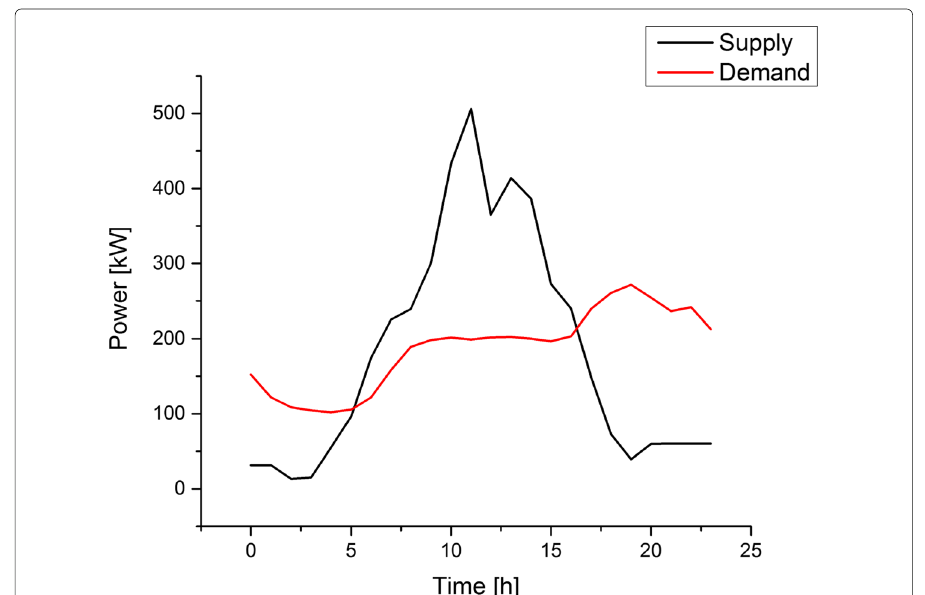
Fig. 4 Aggregate load and production profiles - wind and rooftop solar production